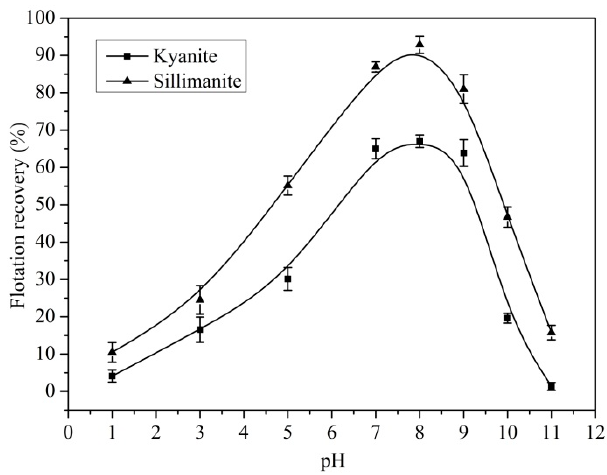
Figure 3. Flotation recovery of kyanite and sillimanite as a function of slurry pH at a sodium oleate concentration of 8.0 × 10 − 4 mol·L − 1 . Error bars represent mean values of three tests ± standard deviation.